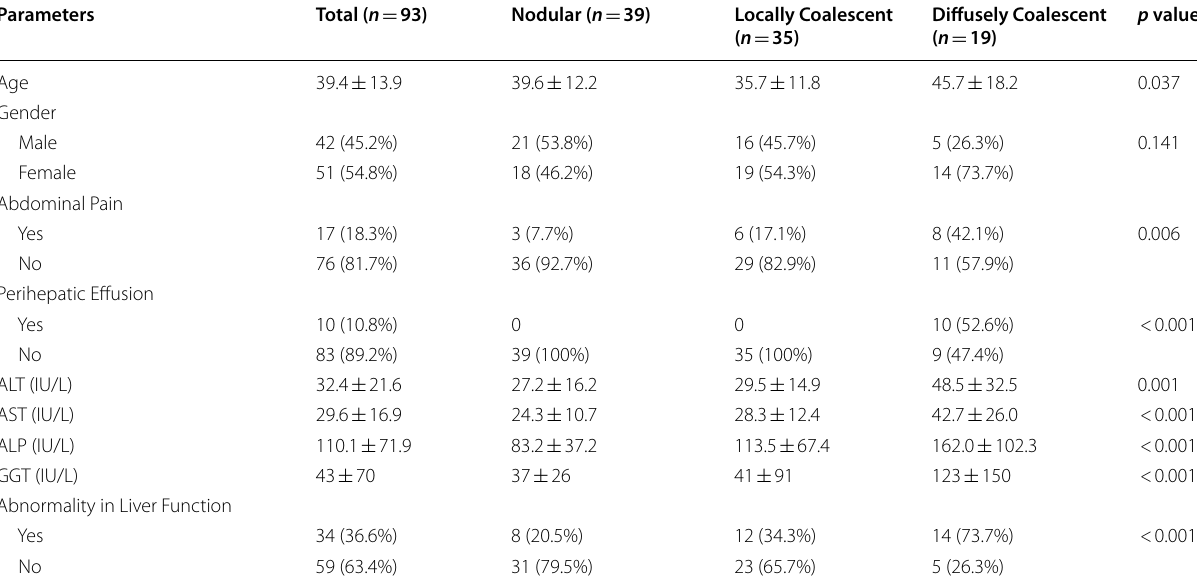
Abnormality in liver function was defined as serum abnormality in any parameter, including ALT, AST, ALP and GGT